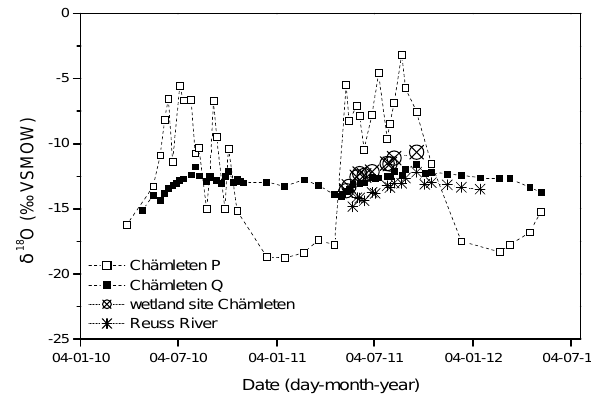
Date (day-month-year) Figure 5: Stable isotopes ( δ 18 O of H 2 O) of subsurface/overland flow in a Chämleten wetland site and the Reuss River. Stable isotope signals of precipitation (P, open symbols) and stream water base flow (Q, filled symbols) of the Chämleten micro catchment are shown for comparison. Fig. 5. Stable isotopes ( δ 18 O of H 2 O) of subsurface/overland flow in a Ch¨amleten wetland site and the Reuss River. Stable isotope sig- nals of precipitation ( P , open symbols) and stream water base flow ( Q , filled symbols) of the Ch¨amleten micro catchment are shown for